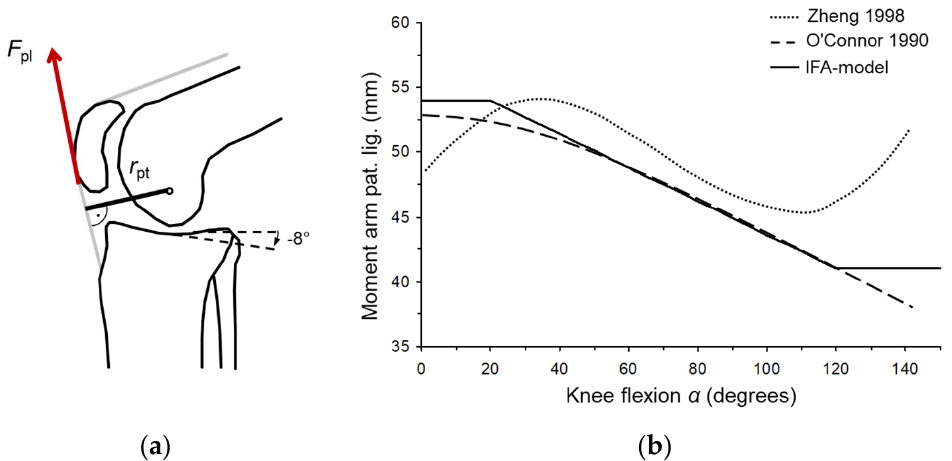
Figure 4. ( a ) Schematic representation of the patellar ligament mechanism and of the sloped tibial weight-bearing surface; ( b ) Piecewise approximation of the moment arm length of the patellar with respect to knee flexion angle compared the data of O’Connor et al. [29] and Zheng et al. [30]. The data from Zheng et al. [30] are depicted for comparison purposes only and have not been used in the IFA-model.